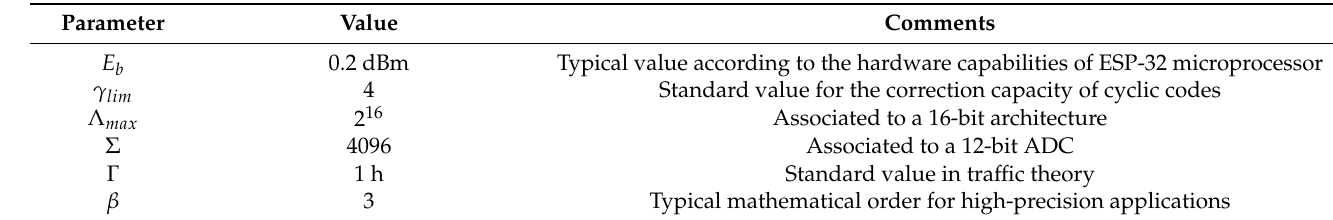
Table 2. Proposed algorithm configuration.